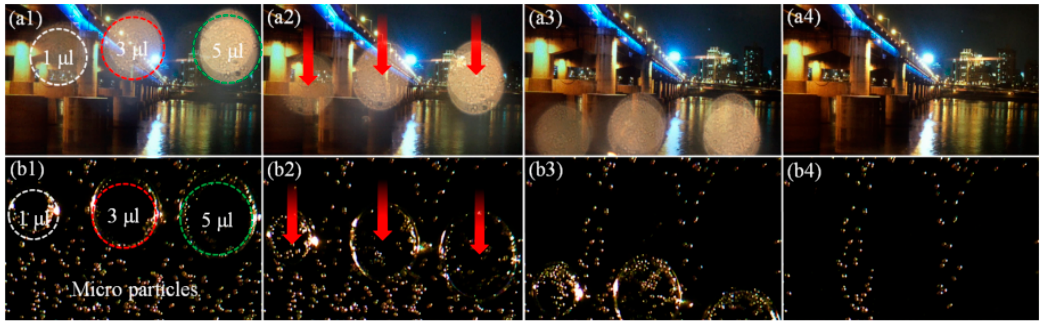
Figure 12. Sequential images of cleaning of ( a ) water droplets and ( b ) particles with different volumes on the lens cover of a smartphone camera. Reproduced with permission from [135], published by Elsevier, 2017.